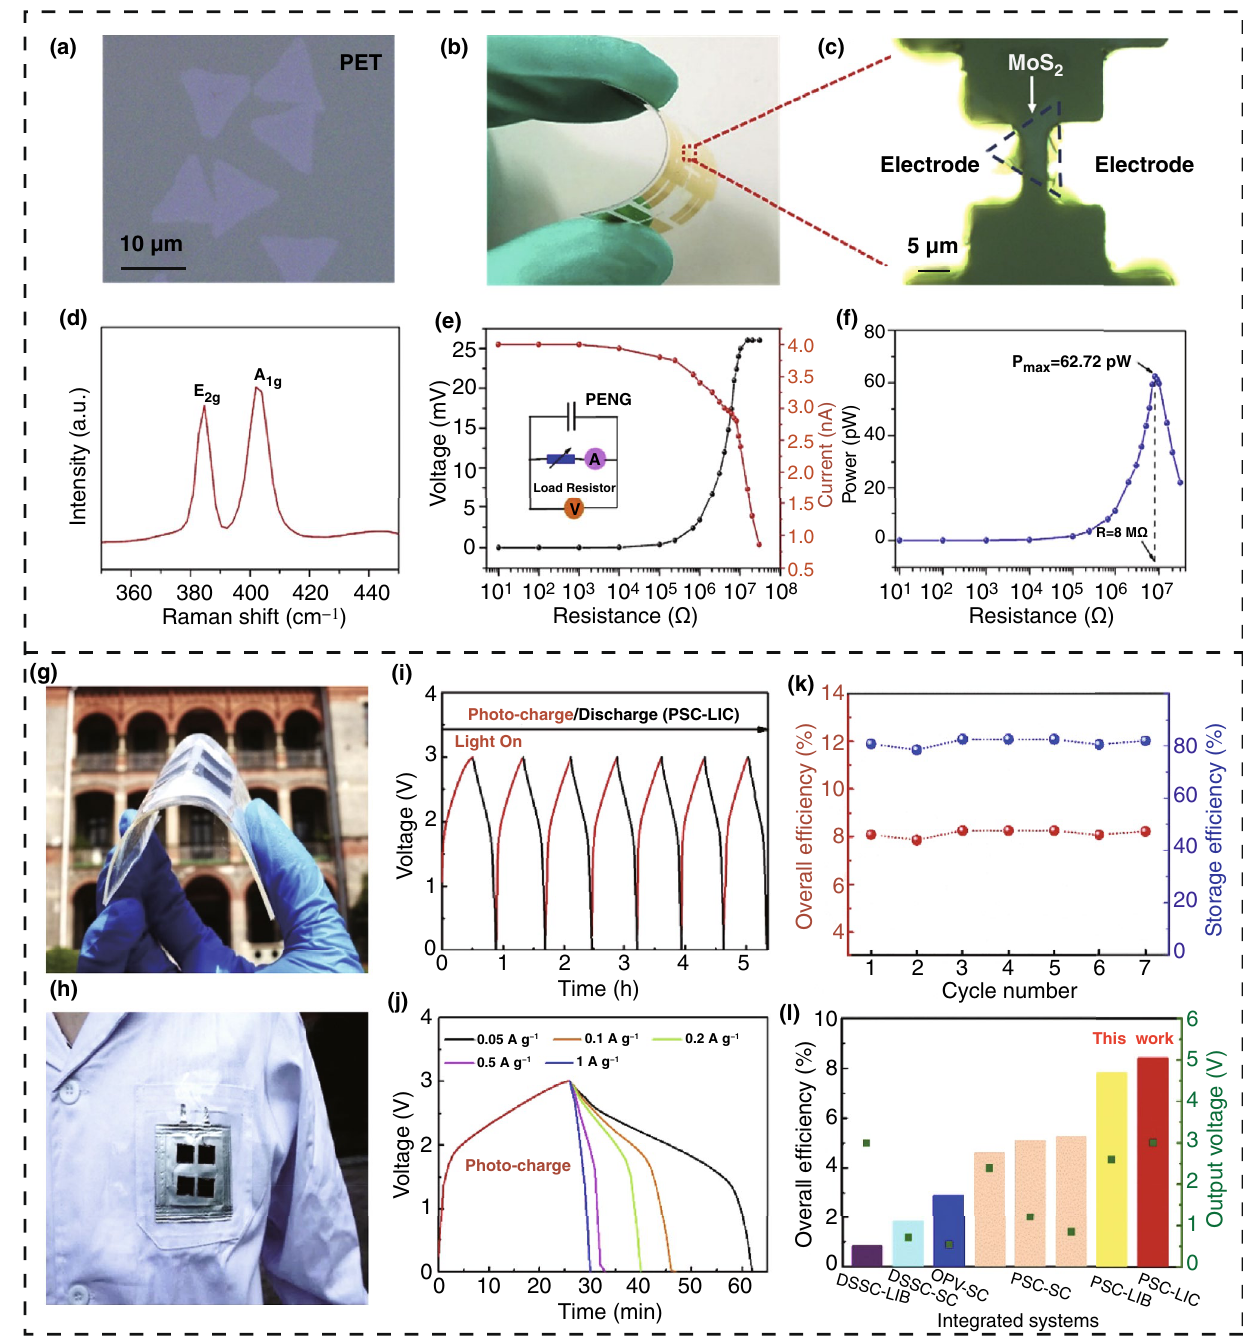
Fig. 11 Nanogenerator-based self-powered sensors based on 2D nanomaterials. a Image of single-layer MoS 2 flake via optical microscope. b Image of flexible piezoelectric nanogenerator. c Image of two electrode-based piezoelectric MoS 2 device. d Raman spectrum of the flake. e Resulting voltage and current with measurement circuit in inset. f Measured power according to external resistance. g Image of flexible perovs- kite solar cell-oriented photo rechargeable lithium-ion device. h Image of device adhered to cloths for real-world application. i Voltage–time characteristics of the device. j Voltage–time characteristics. k Efficiencies of the device. l Comparison of device performance with other inte- grated systems. Figures reprinted with permission from: a , b , c , d , e , f Ref. [131], © 2019 Elsevier; g , h , i , j , k Ref. [135], © 2019